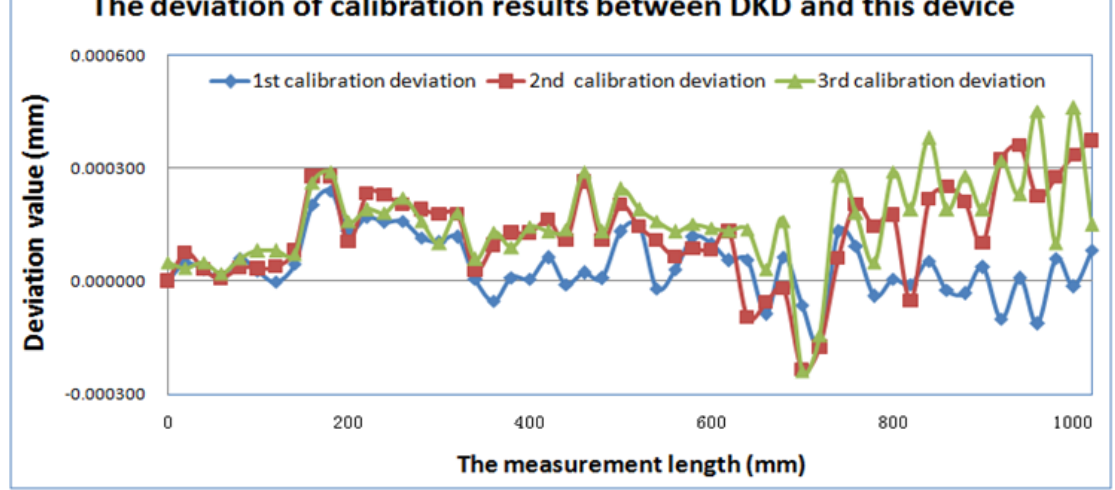
Figure 6. Appl. Sci. 2020 , 10 , x FOR PEER REVIEW